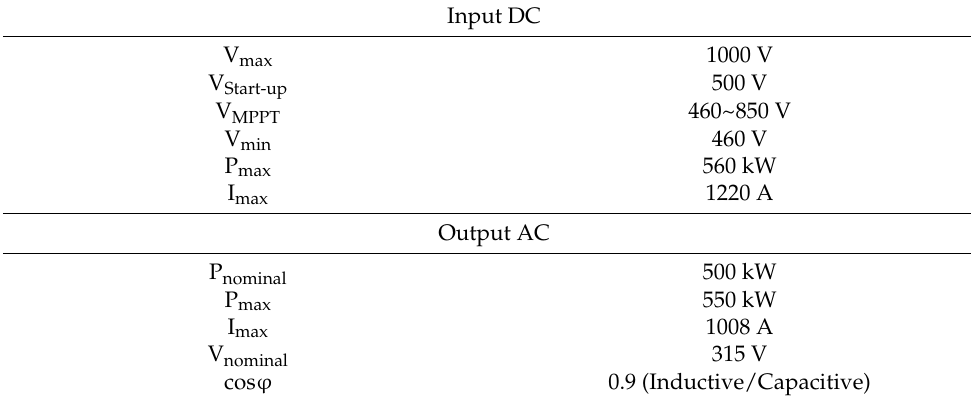
Table 14. Technical sheet data of SG500MX inverter